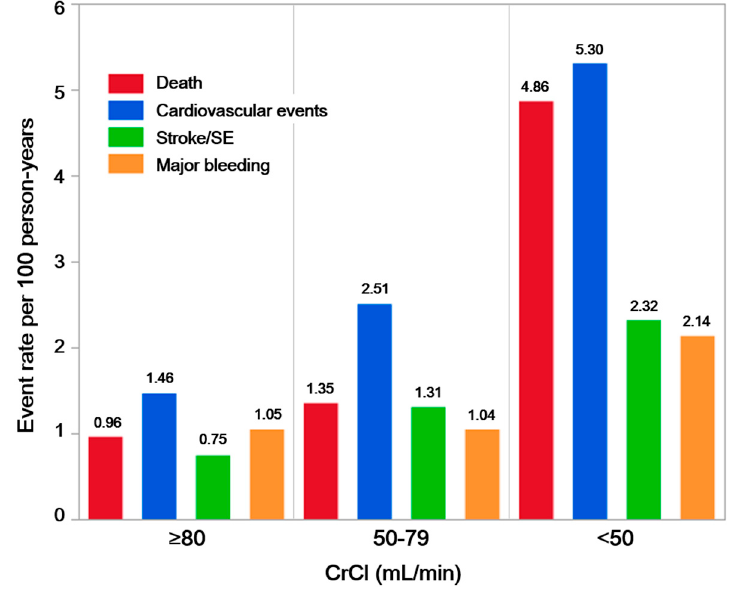
Figure 2. Event rate per 100 patient-years of adverse clinical events for each renal function stratified by the creatinine clearance at study entry.